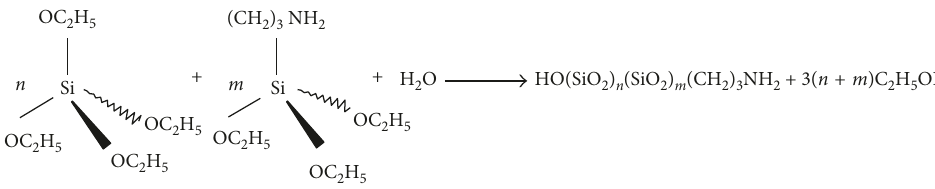
Figure 2: The reaction scheme for the preparation of A-SiO